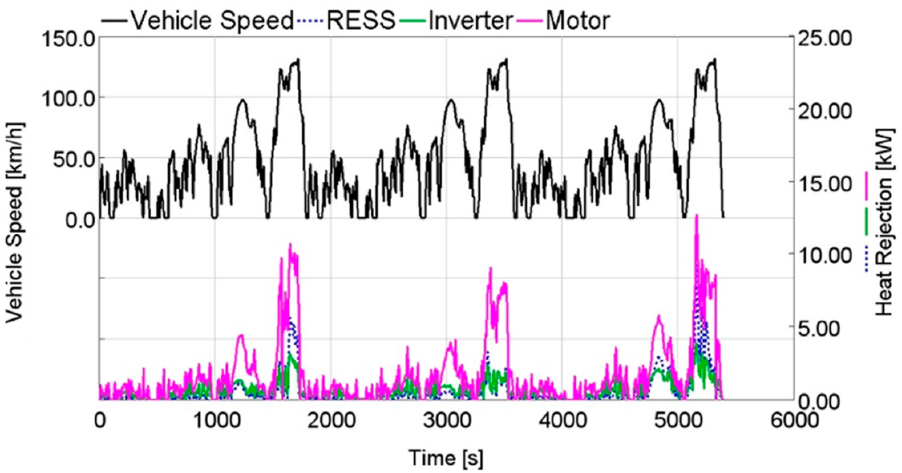
Figure 14. Outputs of the all-electric vehicle model: actual vehicle speed profile (top); motor, inverter and RESS heat rejections vs time (bottom).